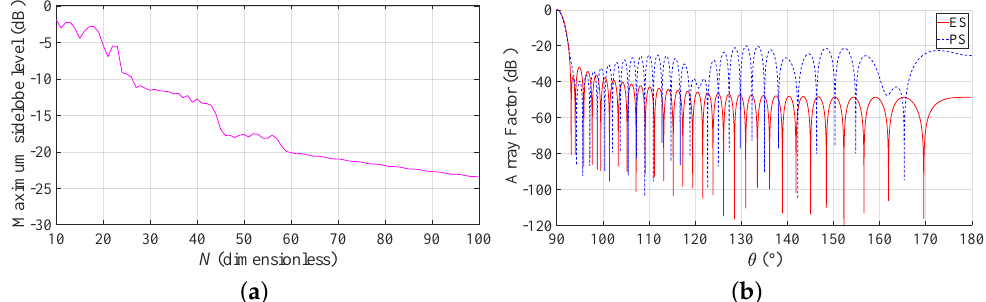
Figure 8. Application example. ( a ) SLL as a function of the number of elements for PS with desired BW = 1 ◦ , b = 3, L / λ = 35. ( b ) The red solid line represents the array factor obtained by ES, and the blue dashed line represents the array factor obtained by